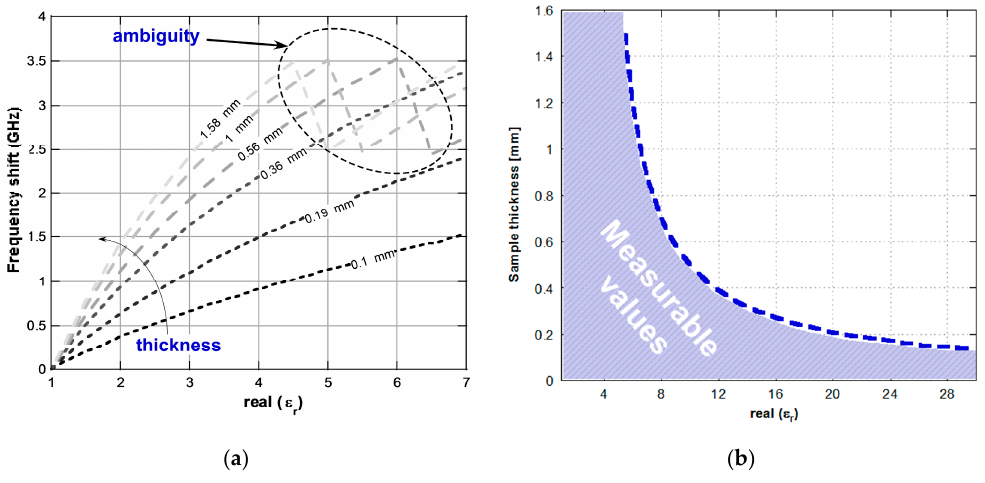
Figure 14. ( a ) Shift-permittivity map: unknown dielectric permittivity as a function of the frequency shift of the resonant peak; ( b ) maximum value of the measurable dielectric permittivity as a function of the sample thickness.